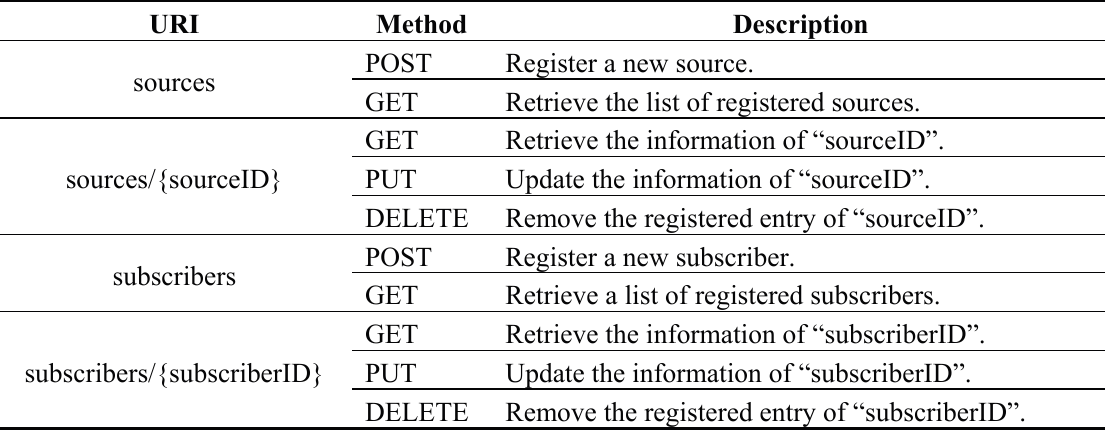
Table 1. Event manager resources